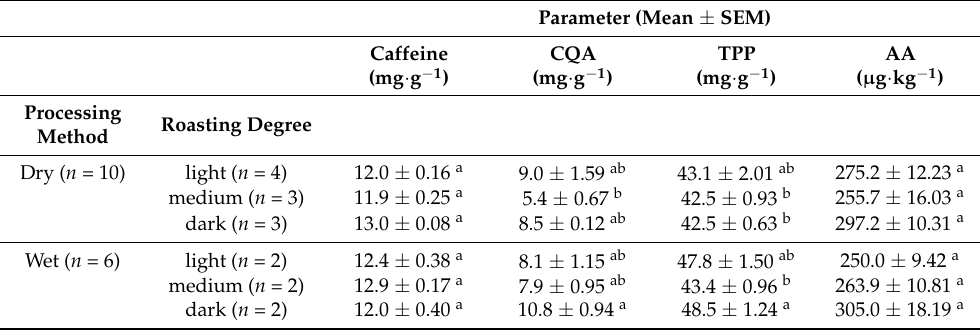
Table 1. Caffeine, chlorogenic acid (CQA), total polyphenols (TPP), and acrylamide (AA) content in the coffee samples were processed by either wet or dry method and consequently roasted to three different degrees: light, medium, and dark, respectively.